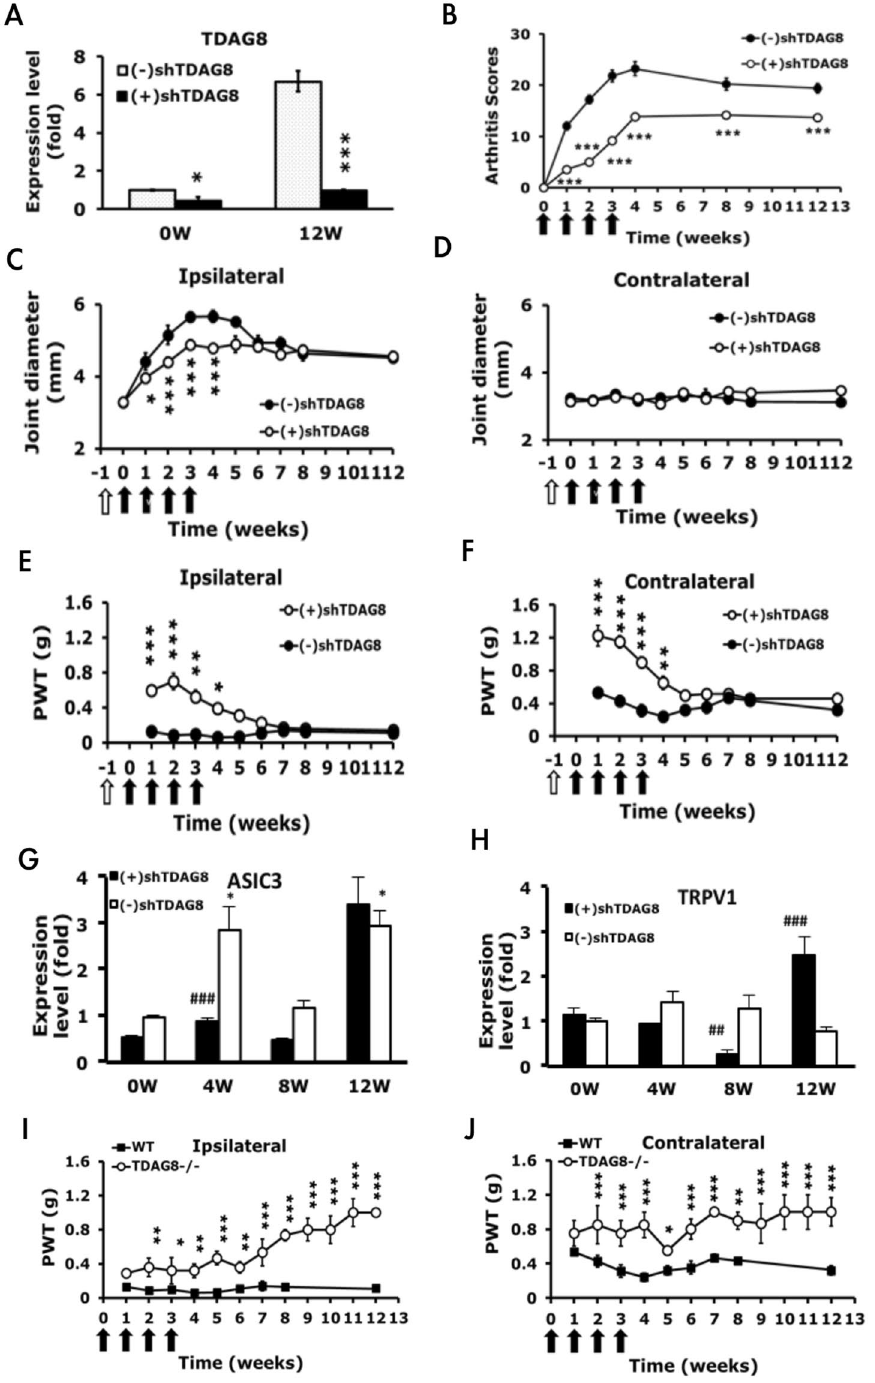
Figure 5. Arthritic TDAG8 knockdown mice show reduced mechanical hyperalgesia in the early phase, but TDAG8 knockout mice attenuated hyperalgesia in both early and late phases. ( A ) TDAG8 gene expression before (0 weeks) or after CFA injection (12 weeks) in L1-5 DRG. * P < 0.05, *** p < 0.001: shTDAG8-injected [( + ) shTDAG8] vs vector-injected mice [( − )shTDAG8] by one-way ANOVA. ( B – D ) Arthritis scores ( B ) and joint diameter ( C , D ) in TDAG8-knockdown mice. * p < 0.05, *** p < 0.001: ( + )shTDAG8 vs ( − )shTDAG8 by two- way ANOVA. ( E , F ) PWT measured at weekly intervals after the first CFA injection. Data are mean ± SEM of total tested mice (n = 6 for ( − )shTDAG8, and n = 8 for ( + )shTDAG8). * p < 0.05, ** P < 0.01, *** p < 0.001: ( + ) shTDAG8 vs ( − )shTDAG8 by two-way ANOVA. ( G , H ) qRT-PCR analysis of ASIC3 or TRPV1 gene expression in ipsilateral L1-5 DRG of TDAG8 knockdown mice. Data are mean ± SEM. * p < 0.05, compared with 0 weeks; ## p < 0.01, ### p < 0.001, compared with WT control by one-way ANOVA. ( I , J ) PWT measured at weekly intervals after the first CFA injection in TDAG8 − / − or WT mice. Data are mean ± SEM of total tested mice (n = 4 for TDAG8 − / − , n = 6 for WT) * p < 0.05, ** P < 0.01, *** p < 0.001: TDAG8 − / − vs WT by two-way